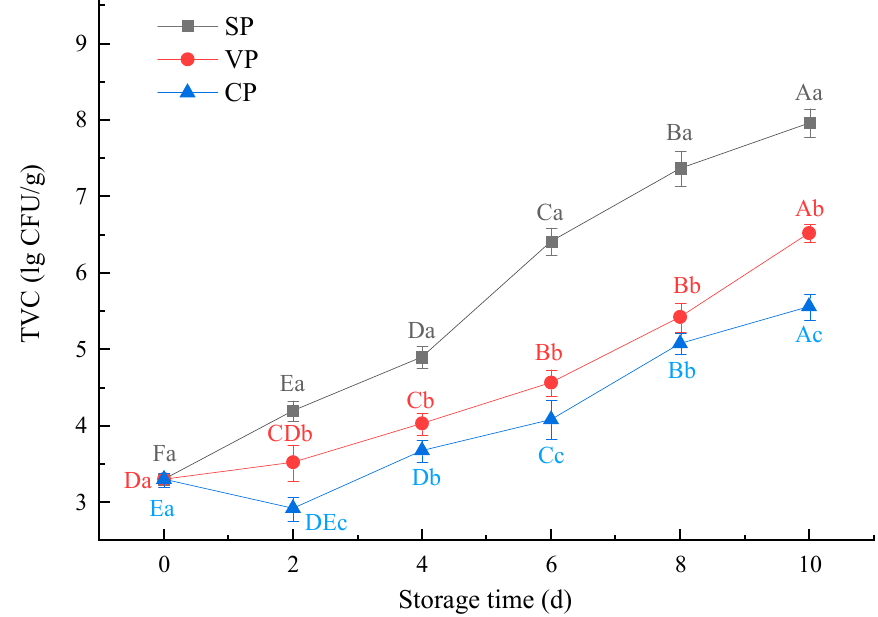
Figure 3. Changes in the total viable count (TVC) of pike eels during 10 days of chilled storage. SP, simple packaging; VP, vacuum packing; and CP, stable chlorine dioxide pretreatment combined with vacuum packing. Different uppercase letters indicate significant differences in the TVC of pike eels during 10 days of chilled storage ( p < 0.05). Different lowercase letters indicate significant differences in the TVC of pike eels for the same storage time ( p < 0.05).